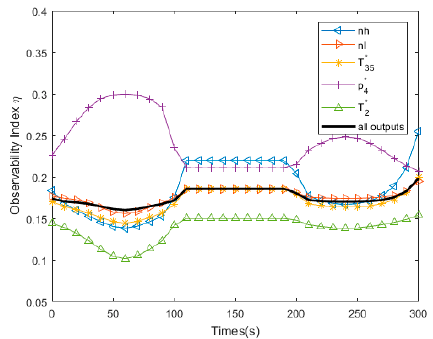
Figure 5. Observability indexes of five CEME model with single output and one with all outputs.